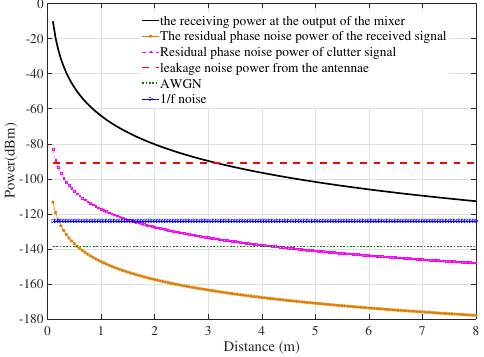
Figure 2. Power of signal and noise of the